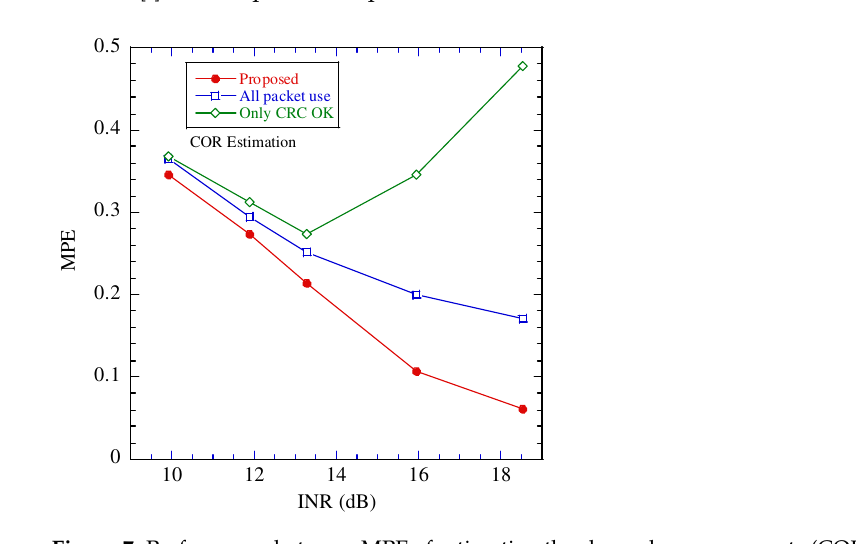
Figure 7. Performance between MPE of estimating the channel occupancy rate (COR) and interference to noise power ratio (INR).